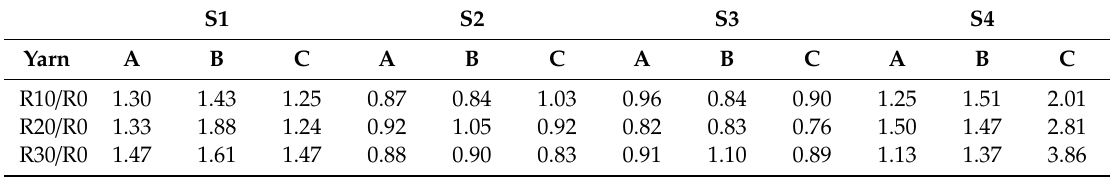
Table 5. Evolution of the sheet resistance of the washed electrodes from different sublots (S1, S2, S3, S4).